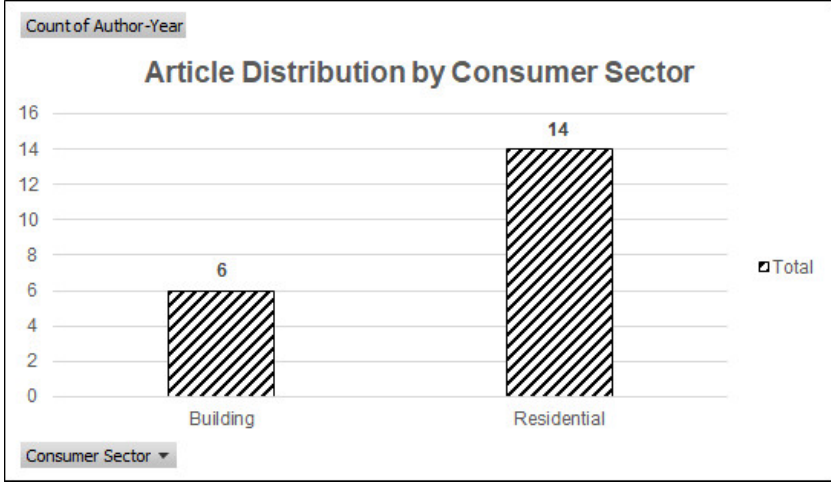
Figure 4. Distribution graph of number of articles by Consumer